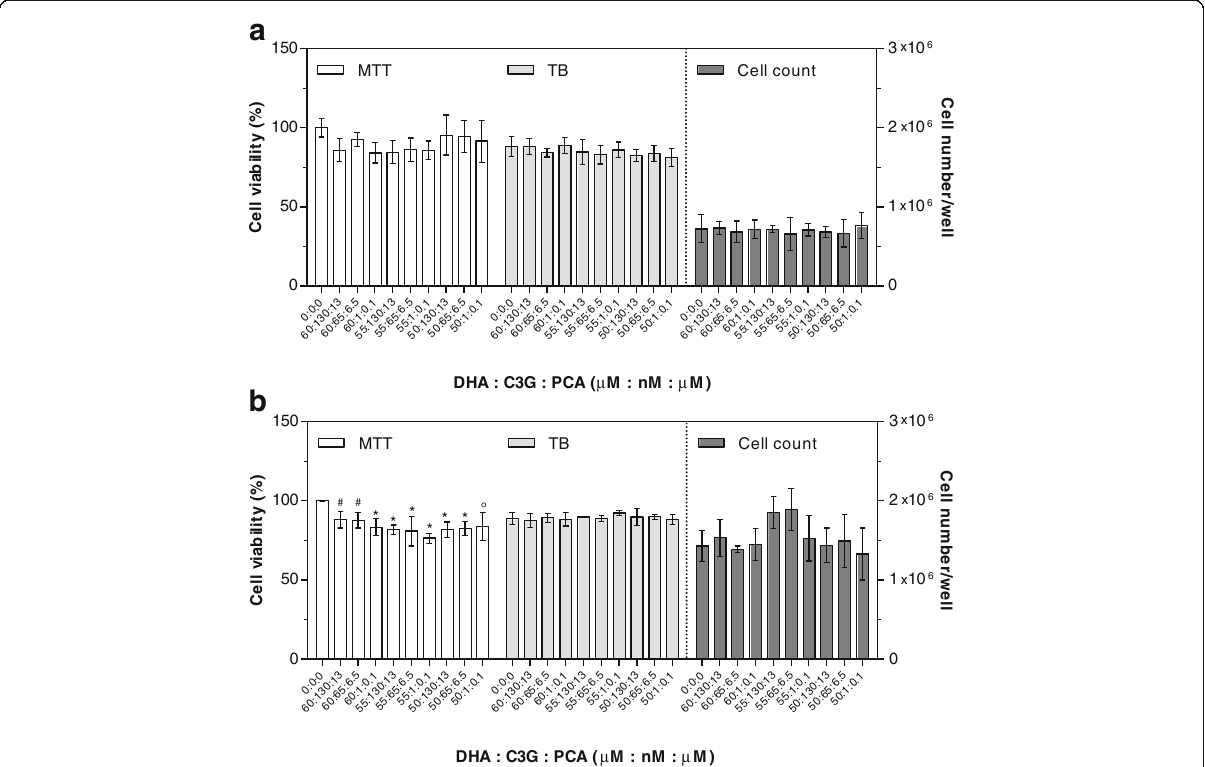
Fig. 8 Cytotoxic effects of DHA plus C3G plus PCA after 24 ( a ) and 48 ( b ) hours of supplementation. Cell viability by MTT is expressed as percentage of control cells (assigned as 100%). TB is expressed as percentage of total cells. Cell count is expressed as number of cells per well. Data are means ± SD of six samples obtained from two independent experiments. Statistical analysis was by the one-way ANOVA (panel a : MTT, TB, and cell count n.s.; panel b : MTT p < 0.001, TB, and cell count n.s.) using Dunnett ’ s as post-test to compare supplemented cells to control ones (# p < 0.05; ° p < 0.01; * p <